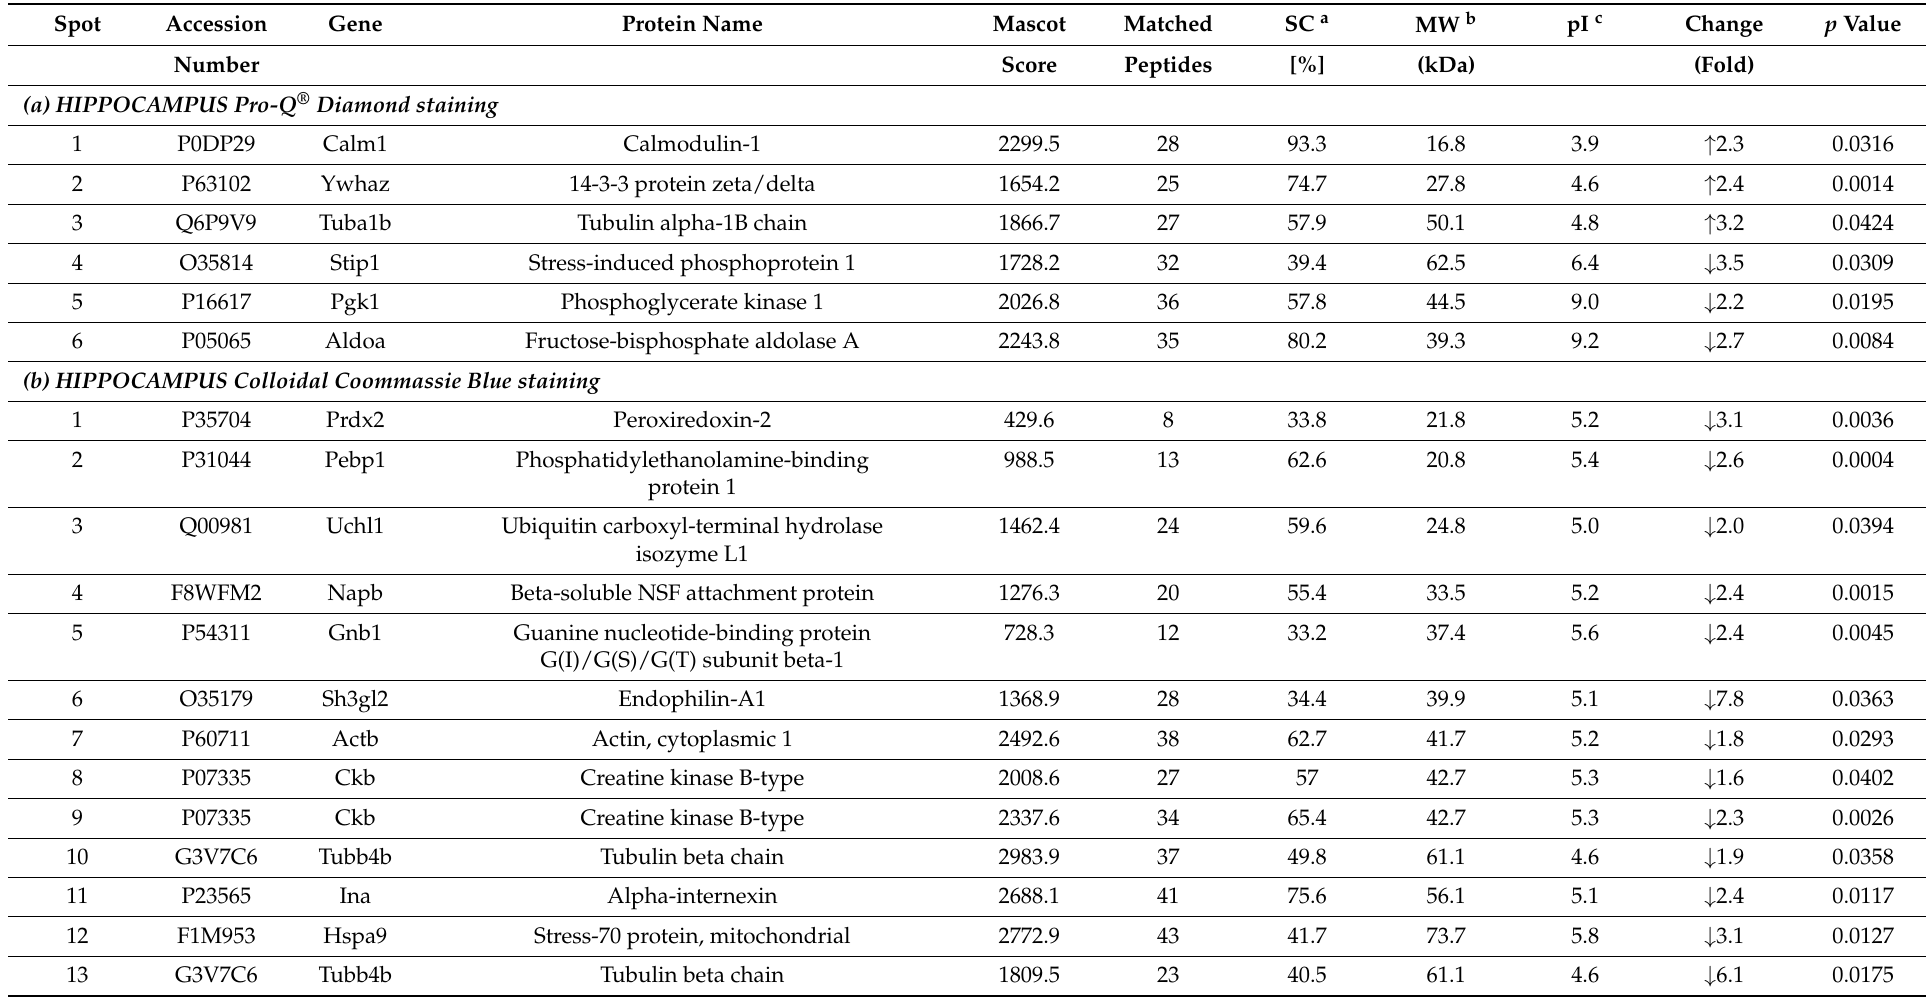
Table 1. nLC-MS/MS analysis of significantly altered protein spots identified in the rat hippocampus ( a , b ) and cortex ( c , d ) isolated from animals after 6 months of morphine